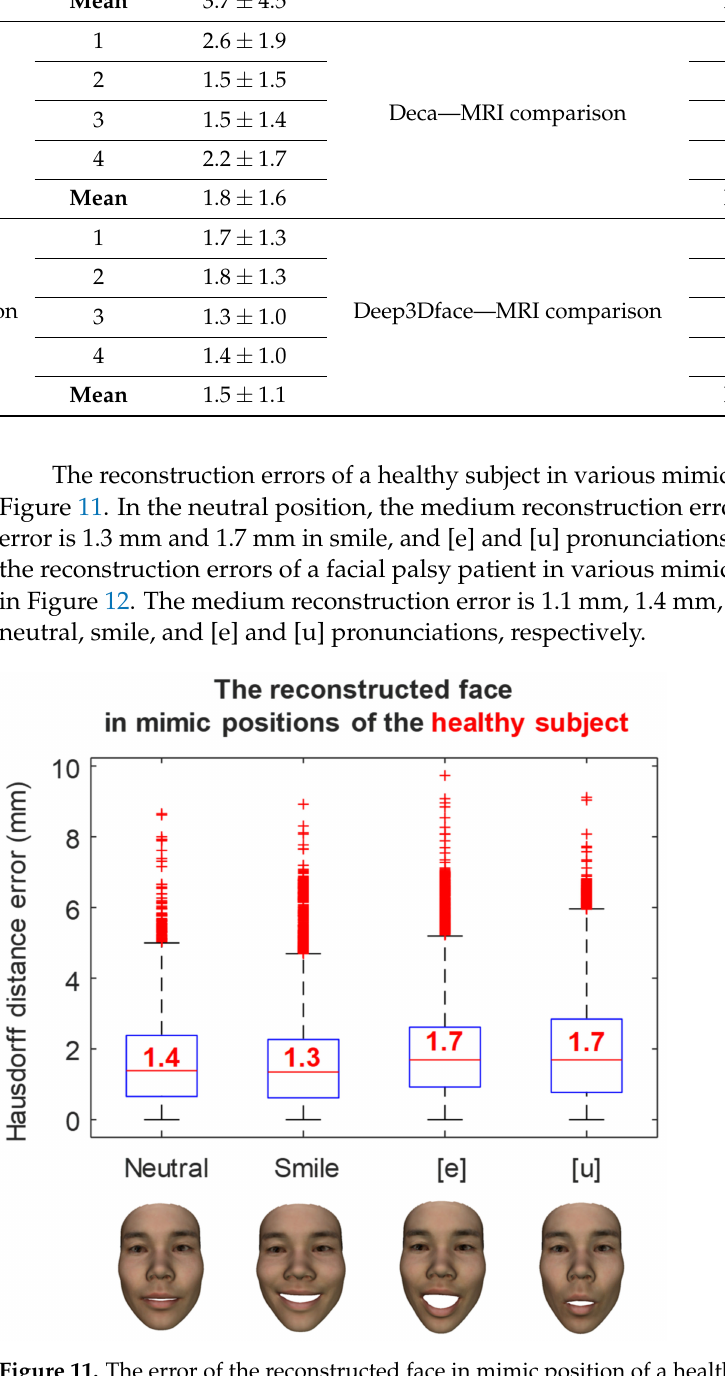
Figure 11. The error of the reconstructed face in mimic position of a healthy